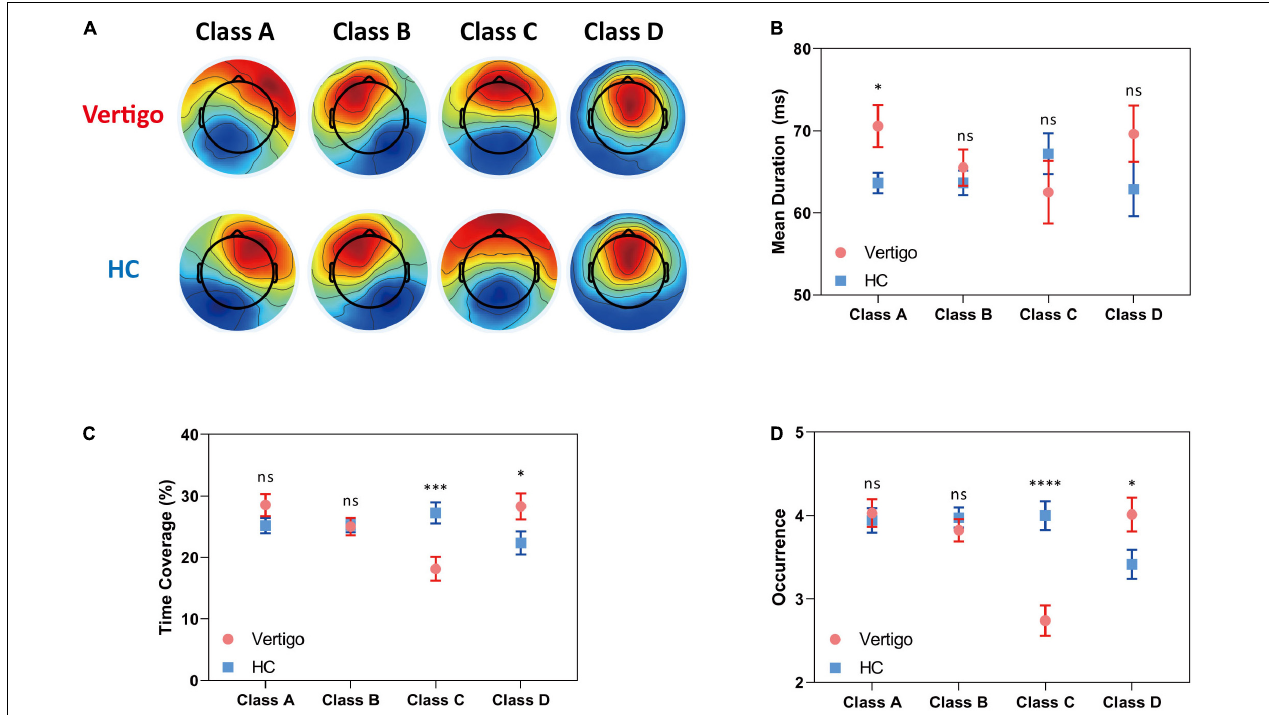
FIGURE 1 | Results of the microstate analysis for patients with vertigo and healthy controls. Data of patients with vertigo are displayed in red and controls in blue. (A) Global architecture of the four microstates (A–D) for both groups. Group average parameters (B) mean duration, (C) time coverage, and (D) occurrence frequency of each class for patients versus healthy controls. Error bars represent SEM. ns, not significant, ∗ p < 0.05, ∗∗∗ p < 0.001, ∗∗∗∗ p < 0.0001 by unpaired t -test.